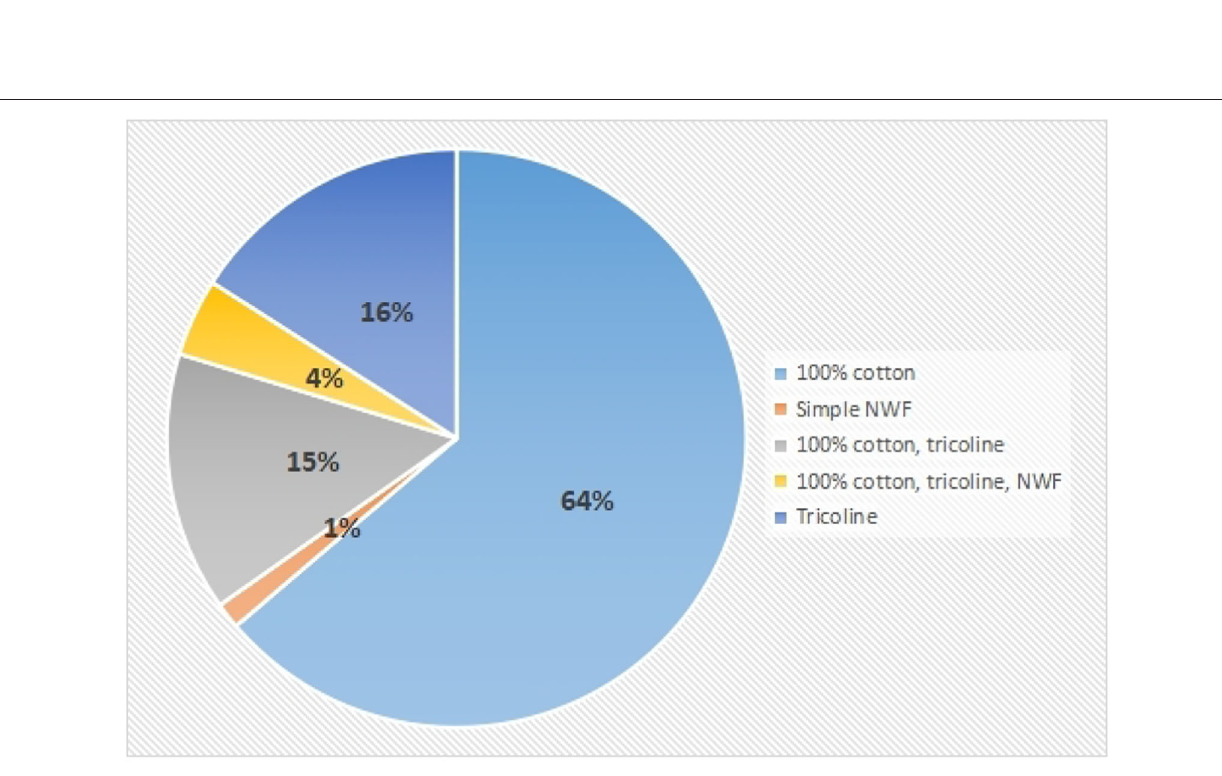
FIGURE 3 | The most common fabric used to make